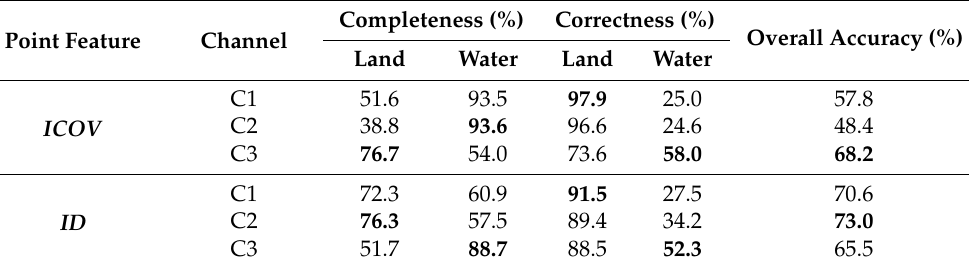
Figure 6. Labeled LiDAR points based on ICOV and ID . Table 6. Accuracy measures of labeled points based on ICOV and ID . The best results are highlighted in bold.